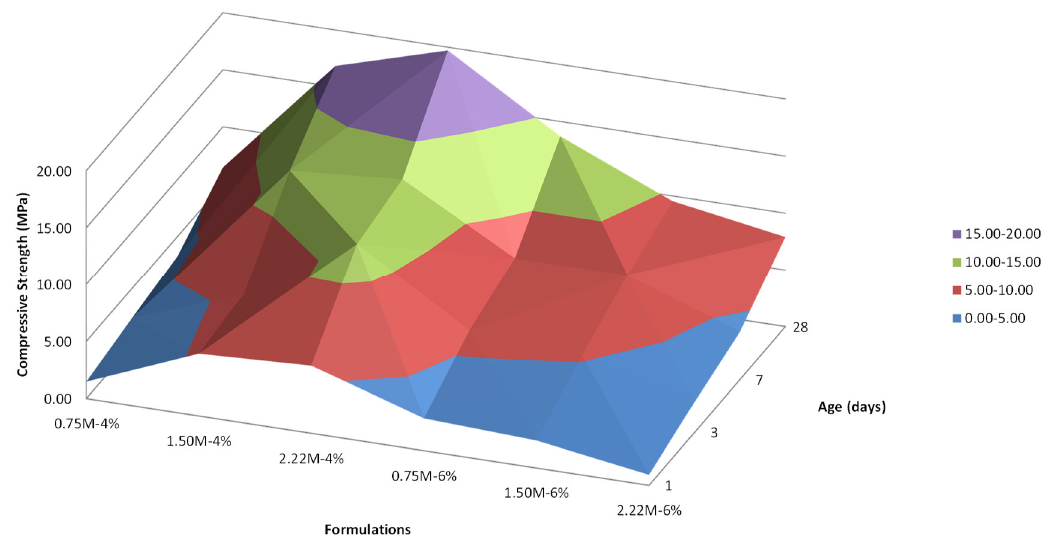
Figure 6. Compressive strength distribution with respect to the formulation and curing age.